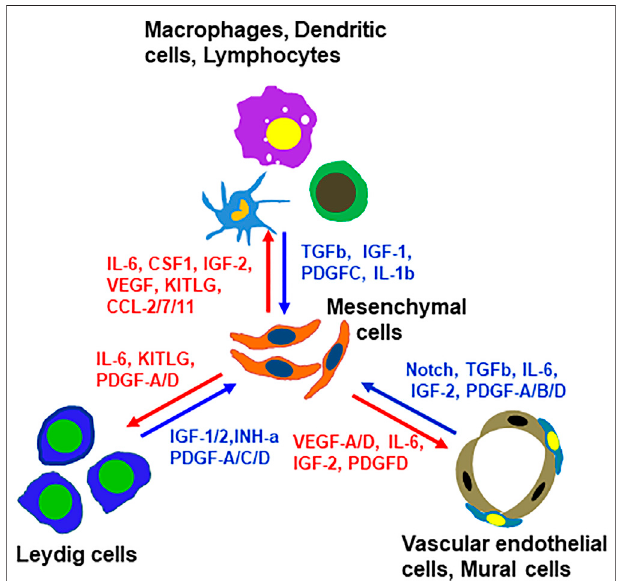
FIGURE 8 | Summary of paracrine factors and their producing cells that have potential to target mesenchymal SLCs or their rounding cells. These factors were selected based on the fact that the ligands are primarily expressed bynon-mesenchymal interstitialcelltypes andtheirreceptors were primarily expressed by mesenchymal cells, or vice